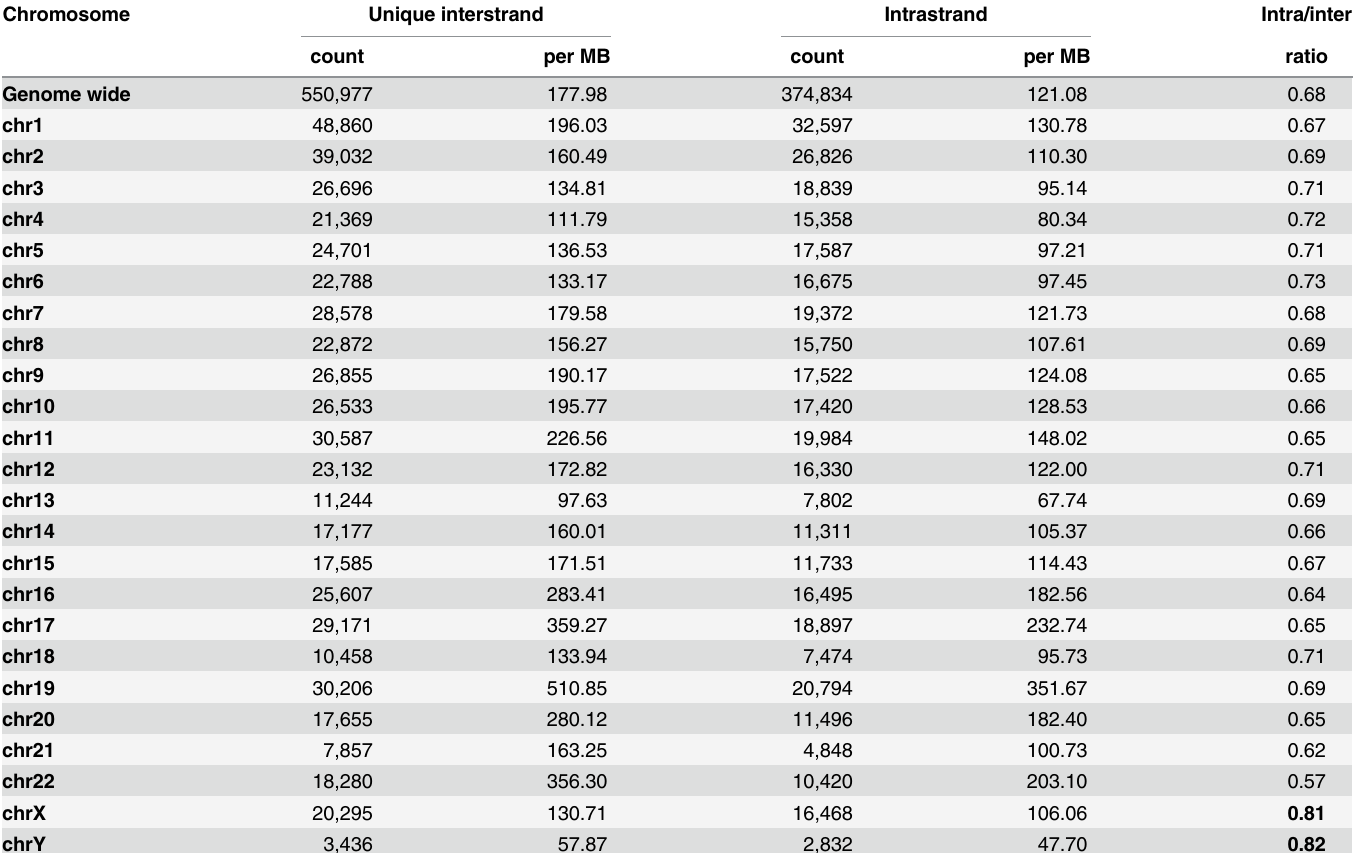
Table 1. Intrastrand and interstrand G-quadruplex sequences by human chromosome.